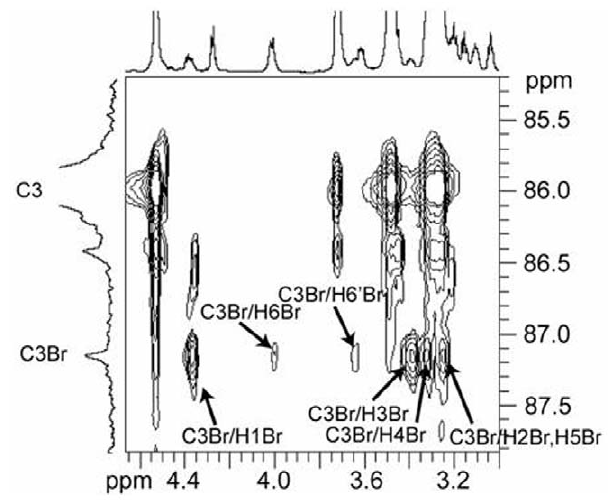
Figure 2. Initial identification of 13 C and 1 H chemical shifts for the branchpoint repeat unit of the (1 R 3,1 R 6)- b -D-glucan isolated from C. glabrata ace2 strain. HSQC-TOCSY 2D NMR spectrum shows correlations between C3 and C3Br carbons and methylene protons in the same spin system as C3Br.